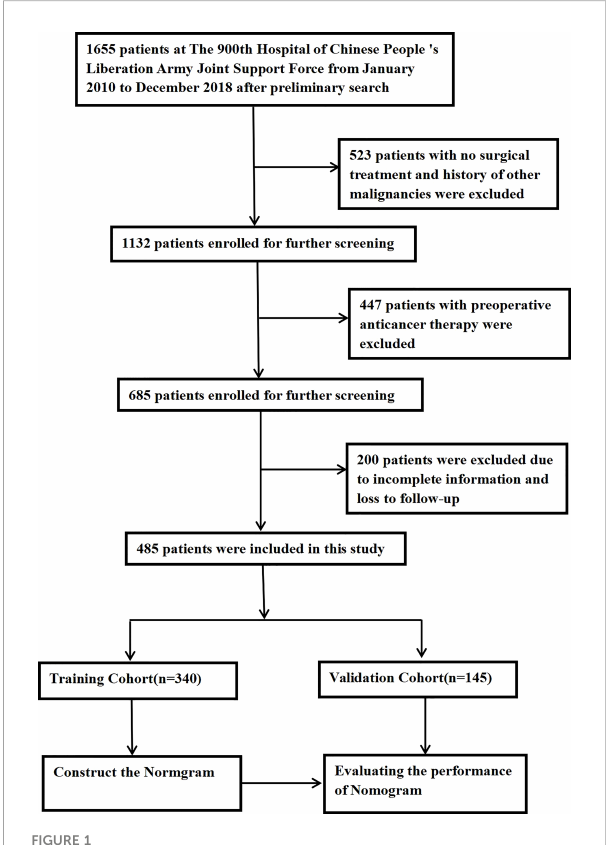
FIGURE 1 Flow chart of the process of patient